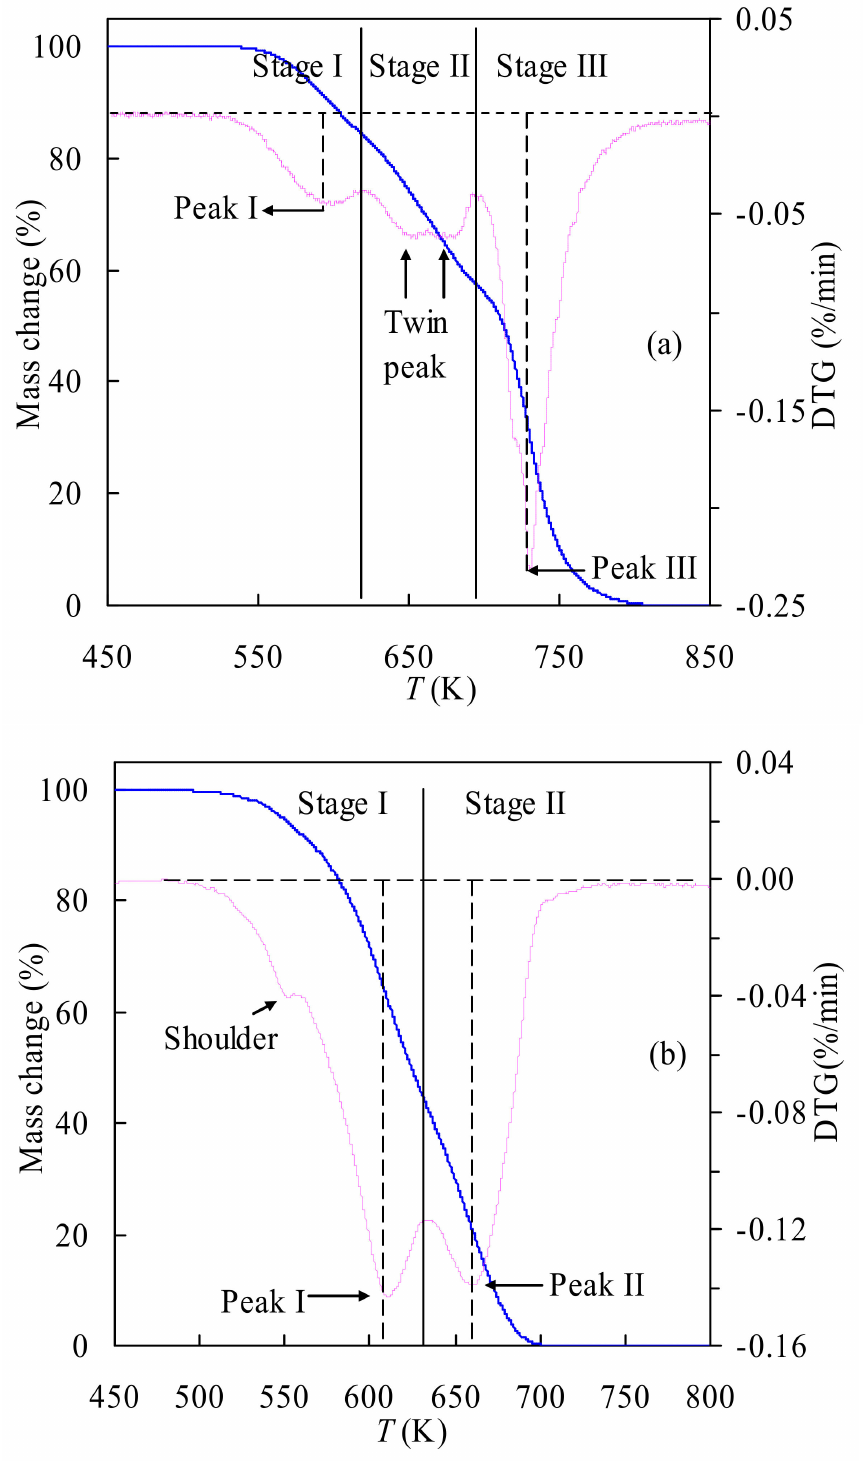
Figure 2. TGA and DTG curves for TSPU ( a ) and WPU ( b ) at β = 15